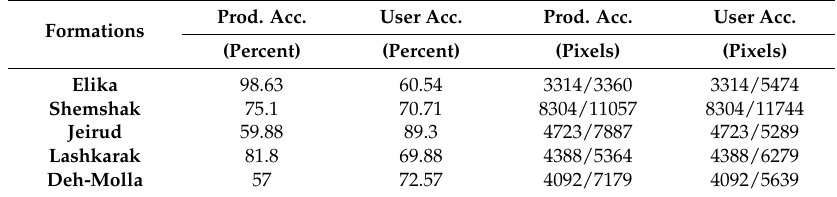
Table 8. Relative accuracy estimated for lithological mapping results based on BRMT method via Shahrood geology